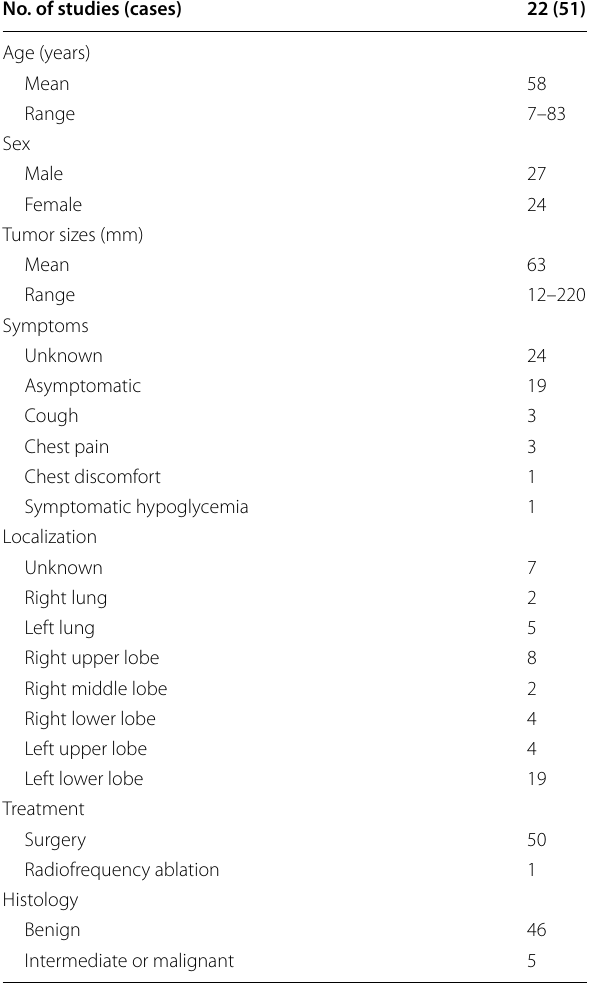
Table 1 Characteristics of the intrapulmonary solitary fibrous tumors present in the English language literature No. of studies